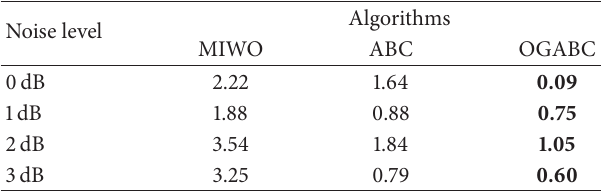
different noise level. The convergence curves indicate that the OGABC is the best algorithm among the three algorithms.